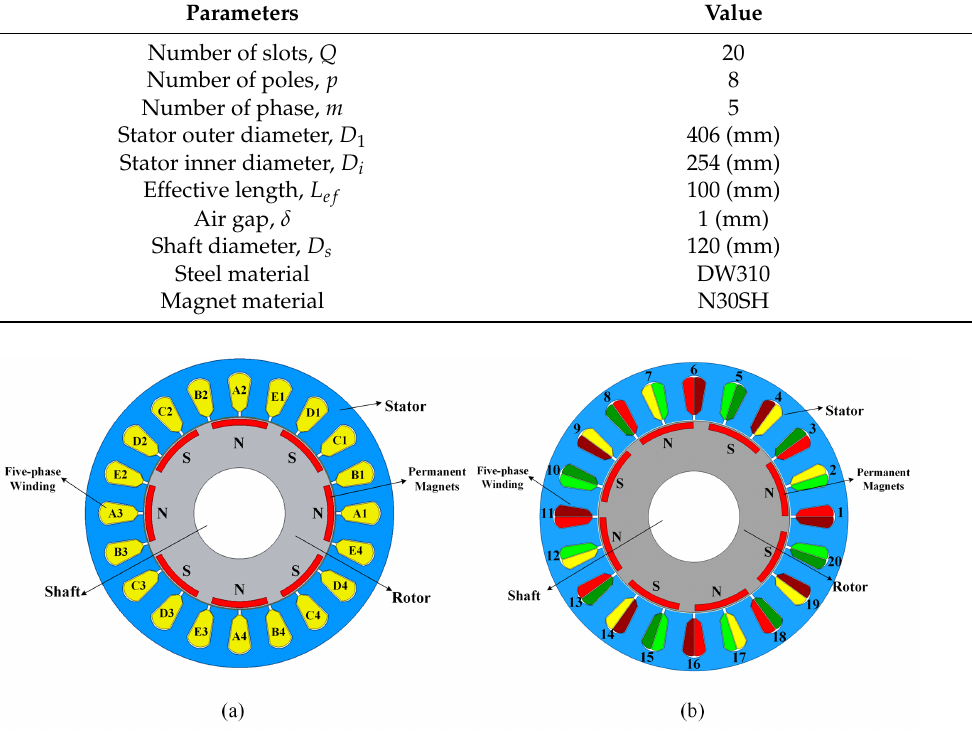
Figure 2. ( a ) Two dimensional topology of five-phase single-turn PMSM. ( b ) Two dimensional topology of conventional distributed five-phase